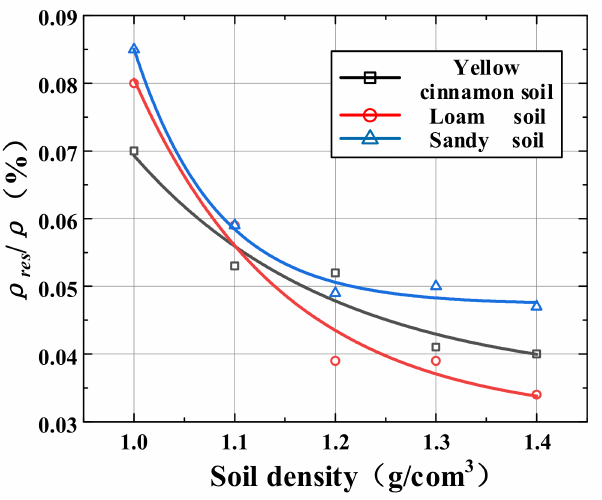
Figure 10. The influence of soil density on ρ res under different soil